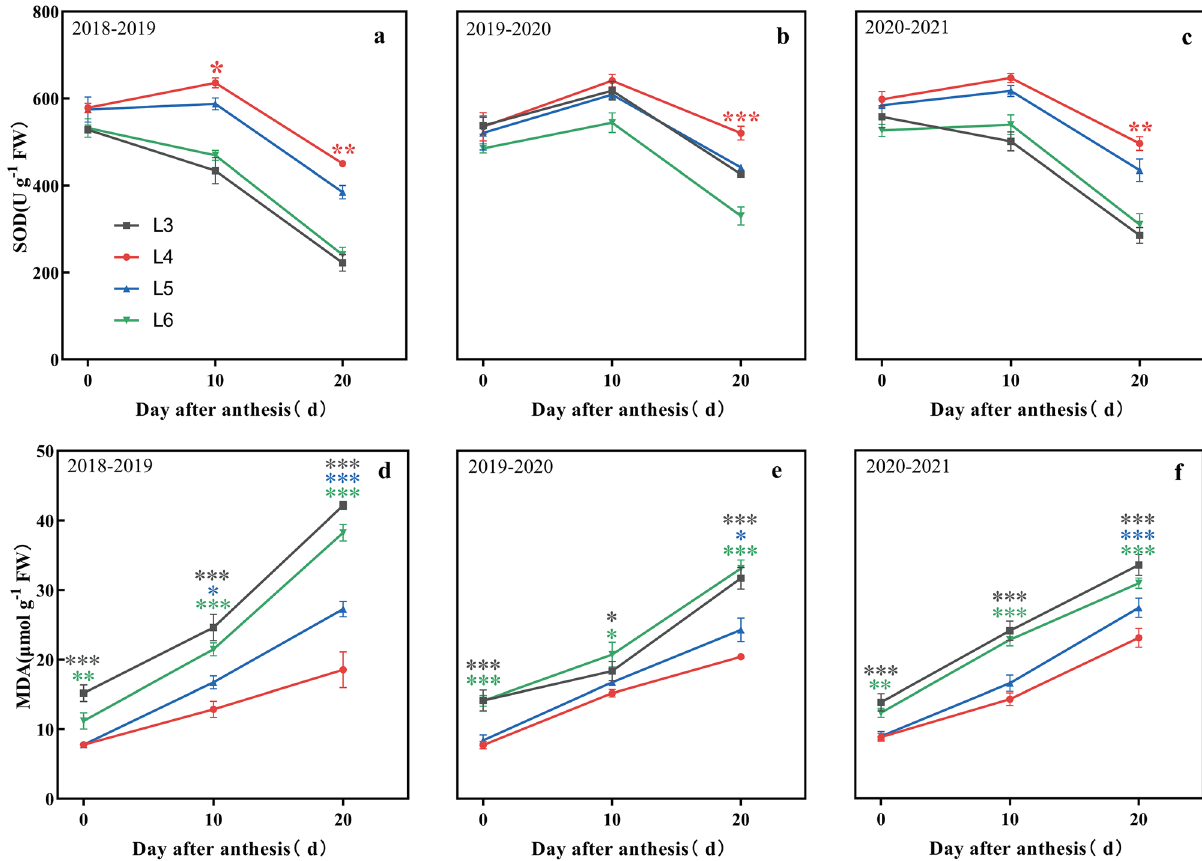
Figure 10. Effects of irrigation time on antioxidant system of flag leaf. SOD, superoxide dismutase; MDA, malondialdehyde. *, ** and *** indicate significance at the 0.05, 0.01 and 0.001 levels,